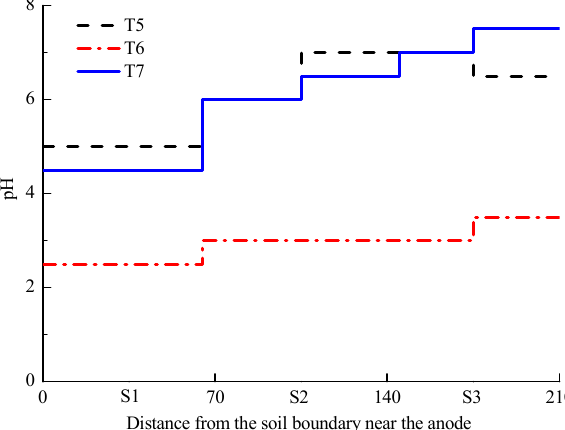
Figure 2. Dry soil pH after EKR treatment of T5–T7.